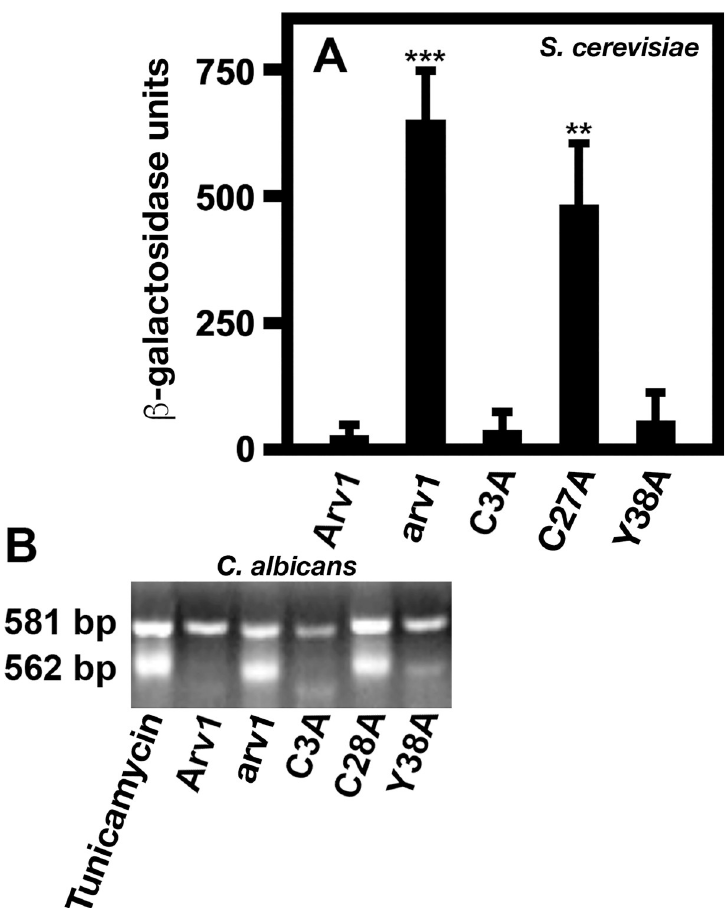
Fig 12. Expression of ScArv1 C27A and CaArv1 C28A activates the unfolded protein response in Scarv1 and Caarv1/ Caarv1 cells, respectively. (A) Scarv1 strains expressing the integrated UPRE-LacZ reporter were grown to exponential phase in the appropriate medium. Cells were assayed for the degree of unfolded protein response activation (UPR) by determining β -galactosidase activity. β -galactosidase activity was assayed as described in Materials and Methods. β -galactosidase units were calculated using a previously published equation [38]. (B) The unfolded protein response was determined in Caarv1/Caarv1 cells by examining the level of HAC1 mRNA splicing using HAC1-5RT (TGAGGATGAACACCAAGAAGAA) and HAC1-3RT ( TCAAAGTCCAACTGAAATGAT ) primers and RT-PCR [39]. The levels of unfolded protein activation in various strains were compared to CaARV1/CaARV1 cells treated with 2 μ g/ml tunicamycin for 2 hr to activate the UPR ( tunicamycin ). Tunicamycin is an antibiotic that is commonly used to activate ER stress and the UPR. The β -galactosidase results shown in panel A are the average of 5 individual experiments. The agarose gel in panel B is a representative of the results of 5 independent experiments �� p � 0 . 001 ; ��� p � 0 . 0001